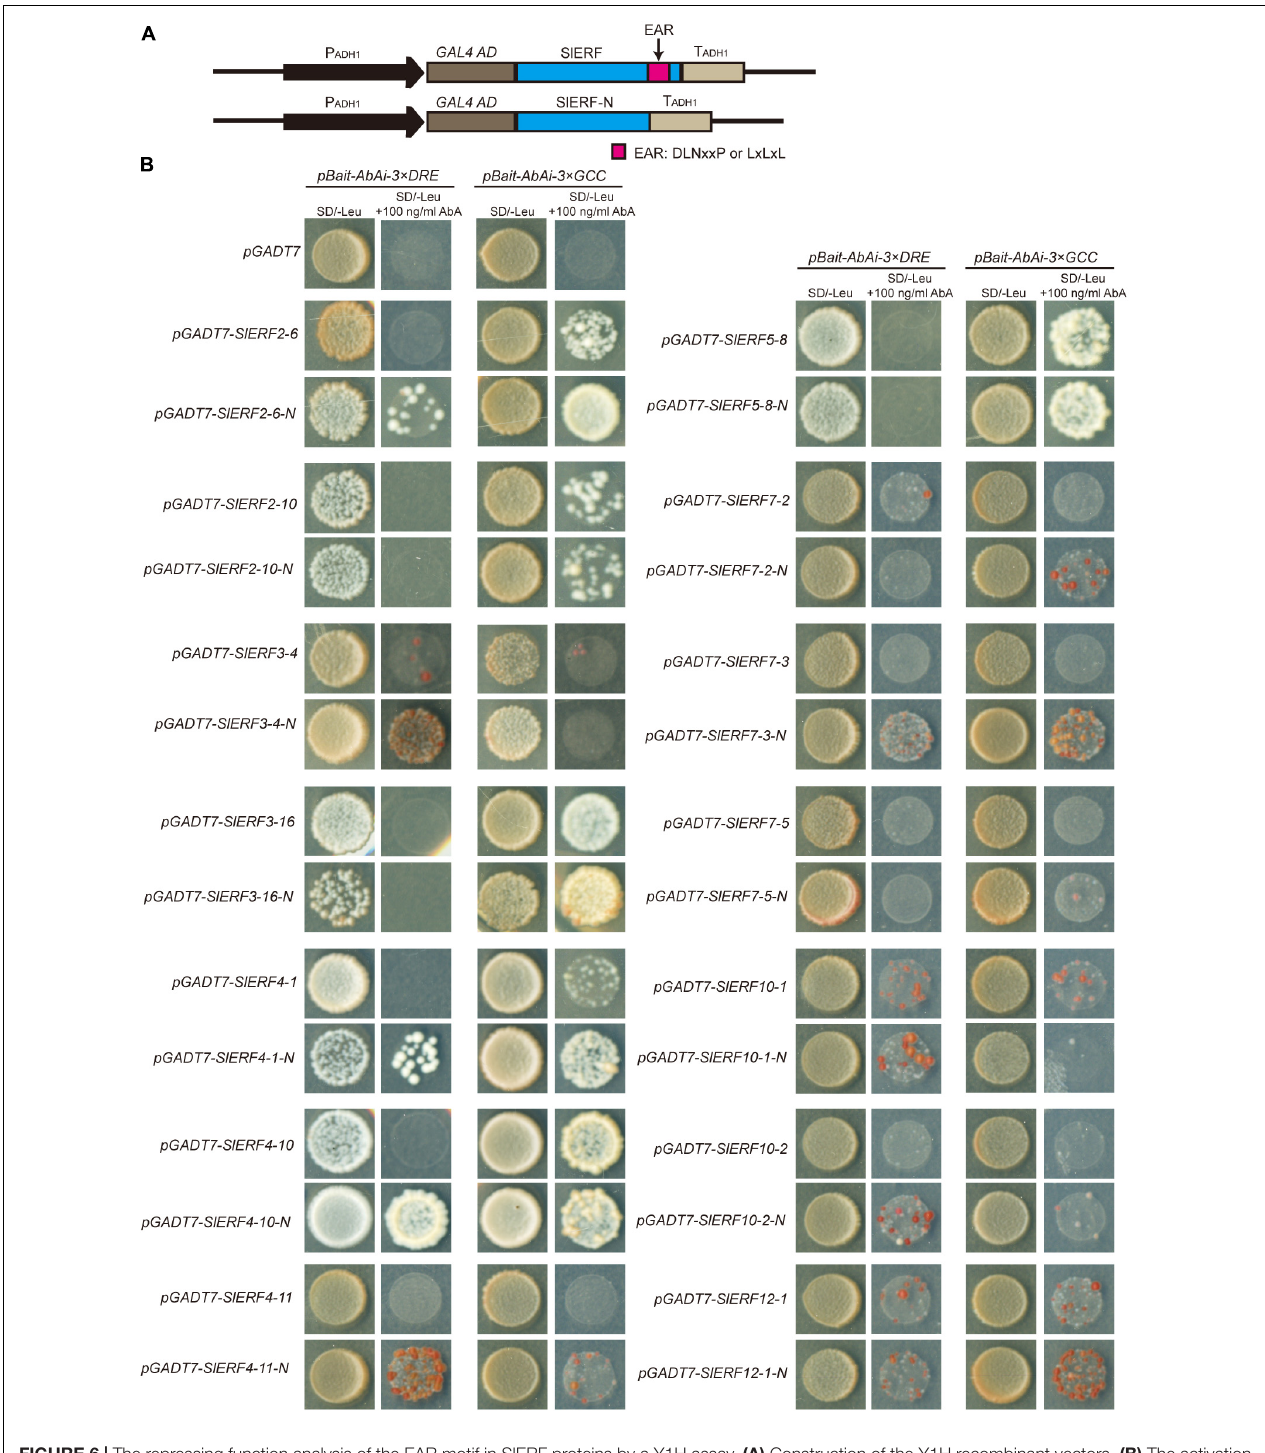
SlERF4-10-N proteins showed scarce changes compared to SlERF2-10, SlERF5-8, or SlERF4-10 proteins. In addition, yeast cells, including SlERF10-1-N proteins, did not even grow